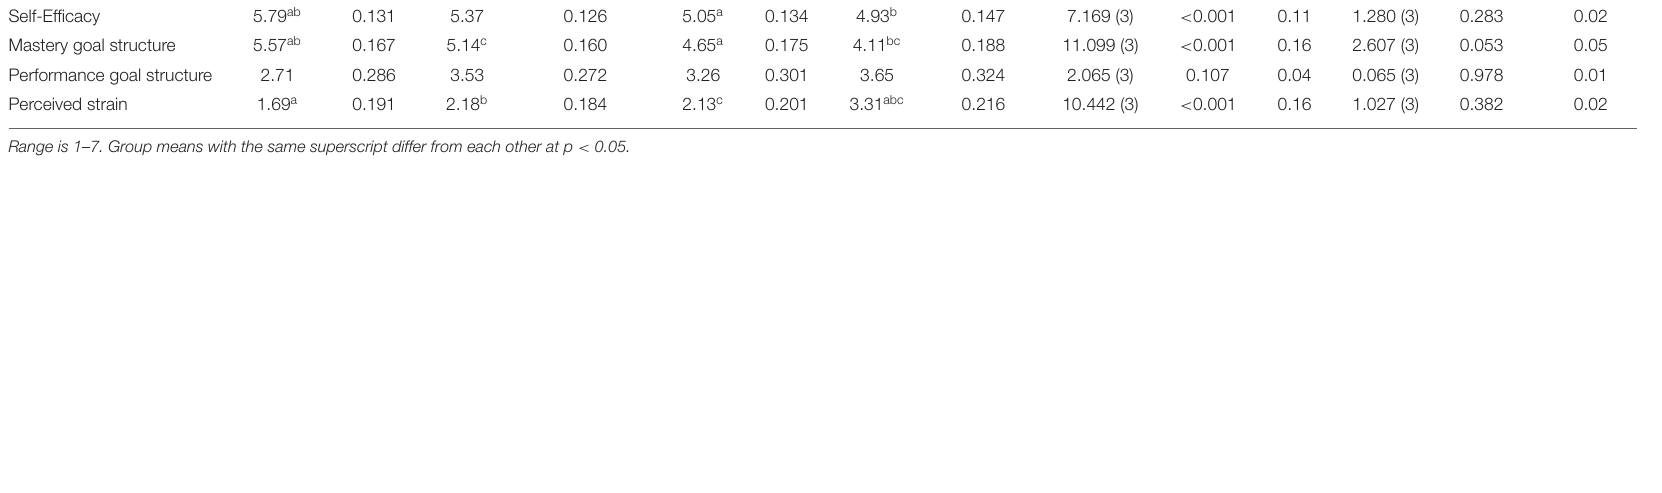
TABLE 6 | Mean differences on self-efficacy, mastery goal structure, performance goal structure, and perceived strain by goal-orientation groups using an executive thinking style as a covariate. Scale Mastery oriented Success-performance Indifferent Avoidance oriented Effect of executive form of